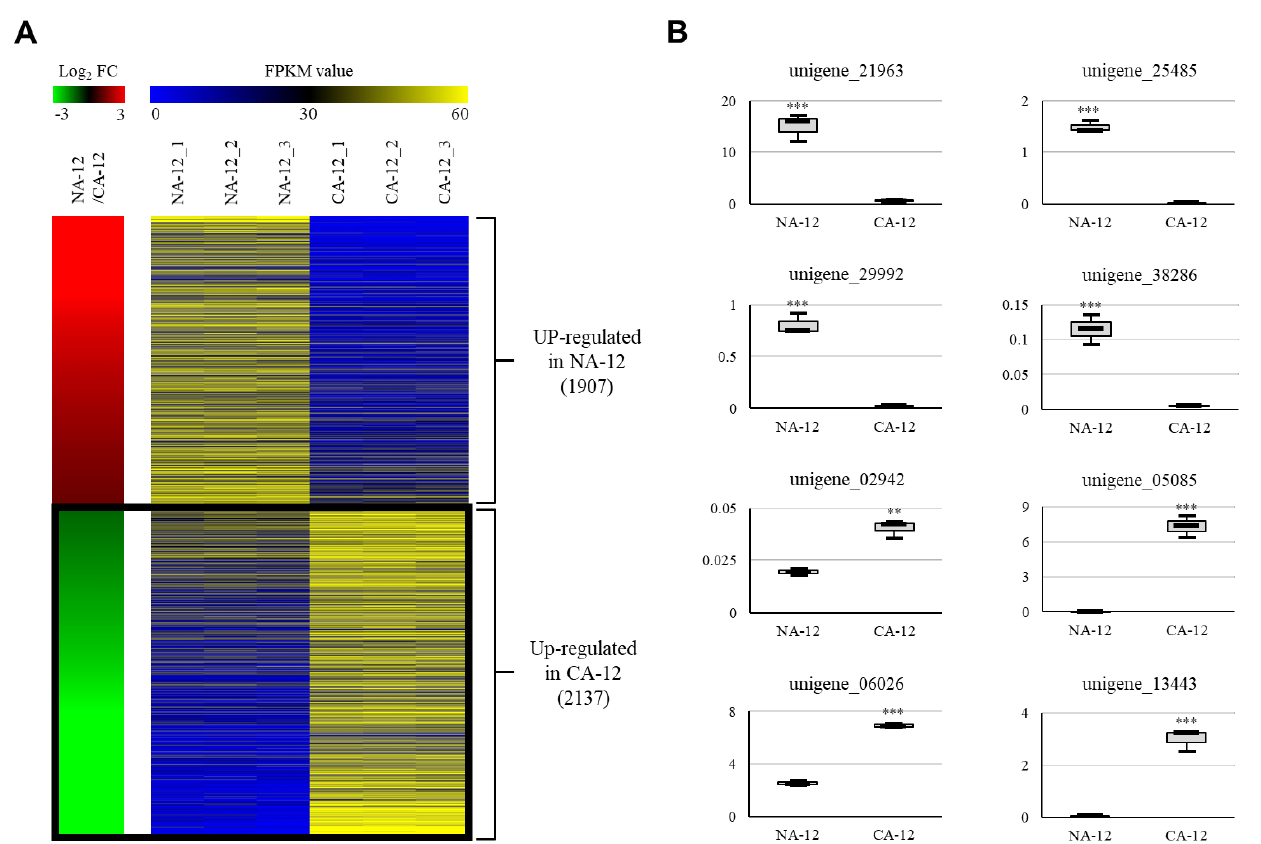
Figure 4. Heatmap of differentially expressed unigenes of CA-12 compared to NA-12. Using RNA-seq data analysis under the criteria of p -value < 0.05 and a log 2 ratio of < − 1 or >1 of NA-12 versus CA-12, we identified 4044 differentially expressed unigenes ( A ). In the left panel, red indicates upregulation in NA-12; green indicates upregulation in CA-12. The right panel shows average normalized FPKM values from RNA-seq experiments; blue indicates the lowest expression level, and yellow is the highest. Detailed data from the RNA-seq analysis are presented in Table S4. The association with the heatmap was further confirmed by monitoring eight genes using qPCR ( B ). The y -axis indicates the expression level relative to EF1/unigene_08701 (internal control), and the x axis indicates samples used for qPCR. Data are means ± SD of three repeats (***, p < 0.001; **, p < 0.01, Student t -test). The primer sequences used for qPCR analysis are shown in Table S5. CA-12, A. turgidum protonema were cold-acclimated at 4 °C for 2 days and exposed to freezing until − 12 °C; NA-12, A. turgidum protonema were non-acclimated at 25 °C for 2 days and exposed to freezing until − 12 °C.